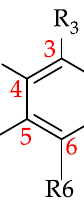
Figure 15. Basic structure of hydroxybenzoic acid and its derivatives (HBADs) (see 110 – 130 in Table 10). Table 10. Hydroxybenzoic acid and its derivatives reported in monofloral honeys (see Figure 15 for general structure).